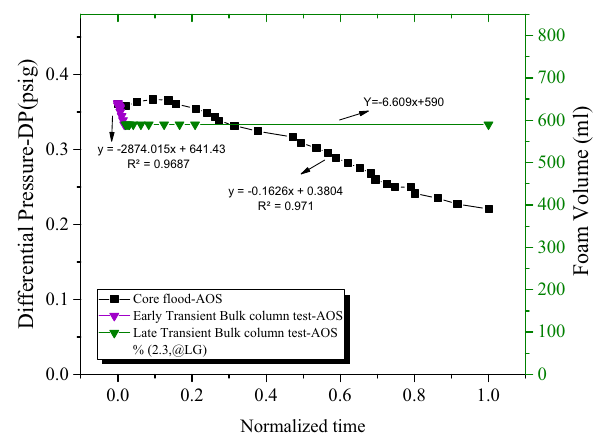
Fig. 9 Side-by-side performance comparison of bulk and coreflood foam stability tests of AOS surfactant